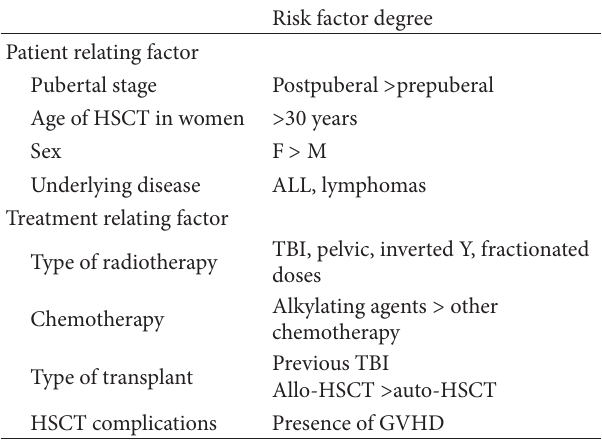
Table 1: Risk factors for gonadal